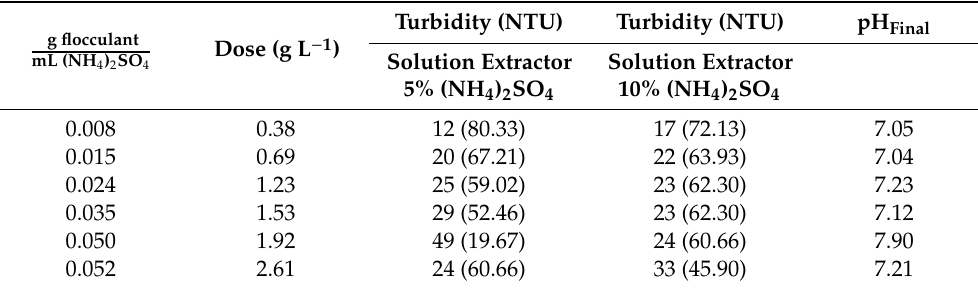
Table 3. Flocculant dose (g L − 1 ) and final turbidity (% removal) obtained from the jar test in S. obliquus culture in urban